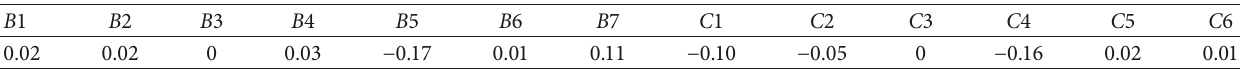
100 regression − ∗ s − 1 kg − 1 ). · ·